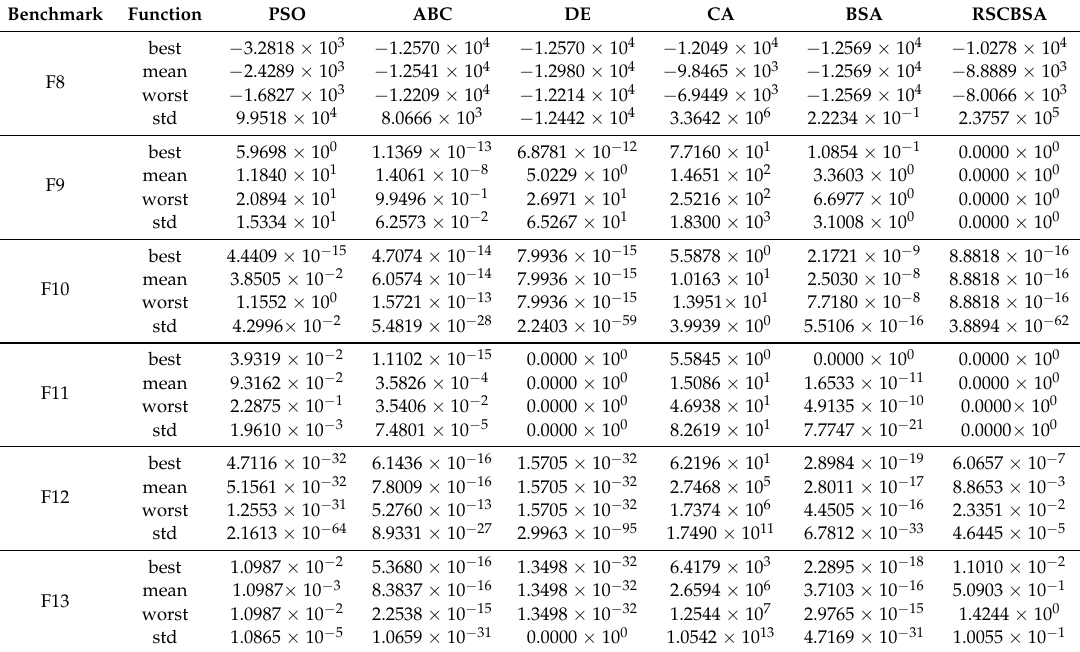
Table 3. Results of multimodal benchmark functions.